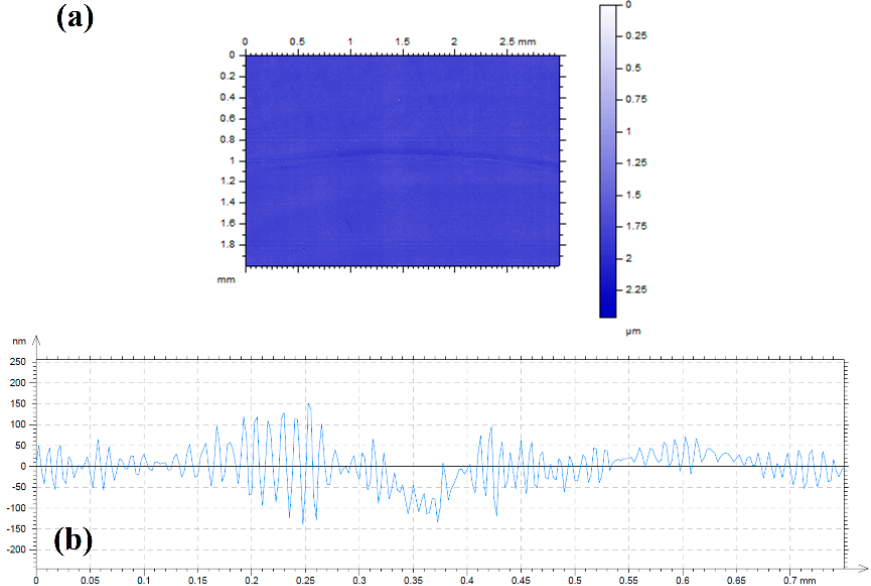
Figure 11. ( a ) Surface topography and ( b ) cross sectional profile of the wear track on AISI 316L disk after lubrication with the dispersion of nanoparticles in linseed oil.